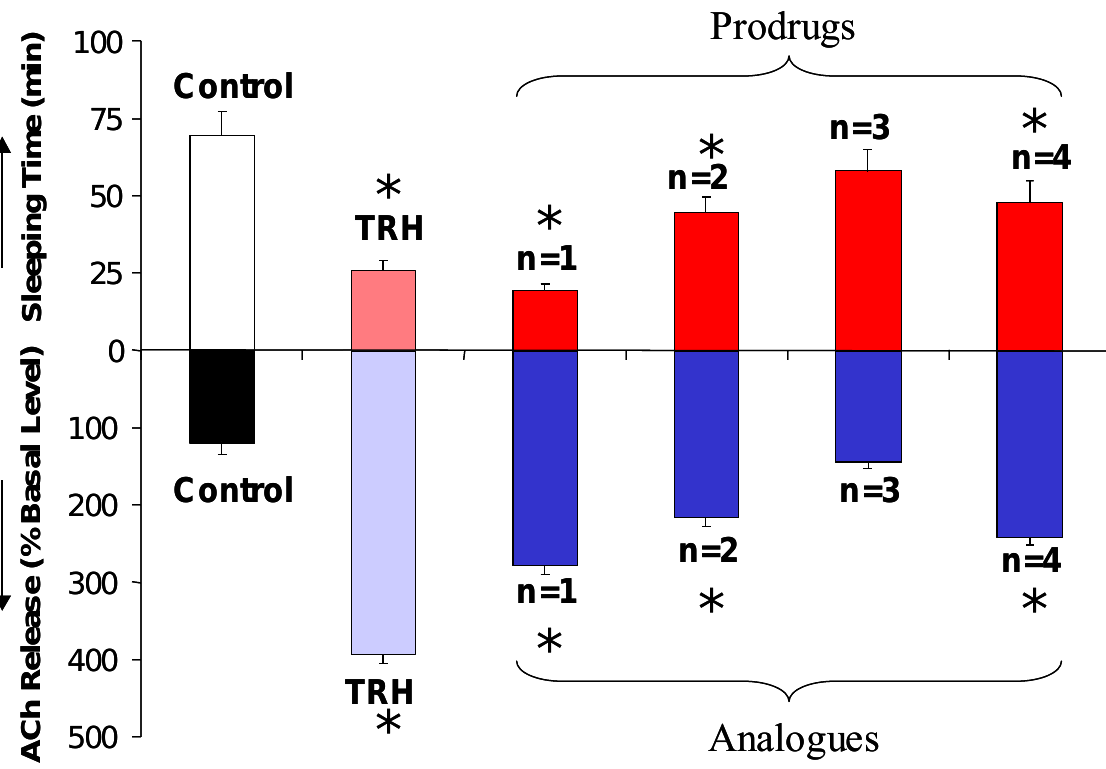
Figure 5. Parallel trends between the analeptic potency (i.v. injection at equimolar dose of 15 μ mol/kg body weight as prodrugs) and ACh-releasing effect (perfusion of the analogues into the hippocampus by microdialysis at equimolar concentrations of 1 nmol/µl) of the novel [pyridinium 2 ]TRH analogues shown in Figure 4 together with those of TRH and control (saline vehicle), respectively. * P <0.05 vs. vehicle control. Reprinted with permission from [65]. © 2004 American Chemical